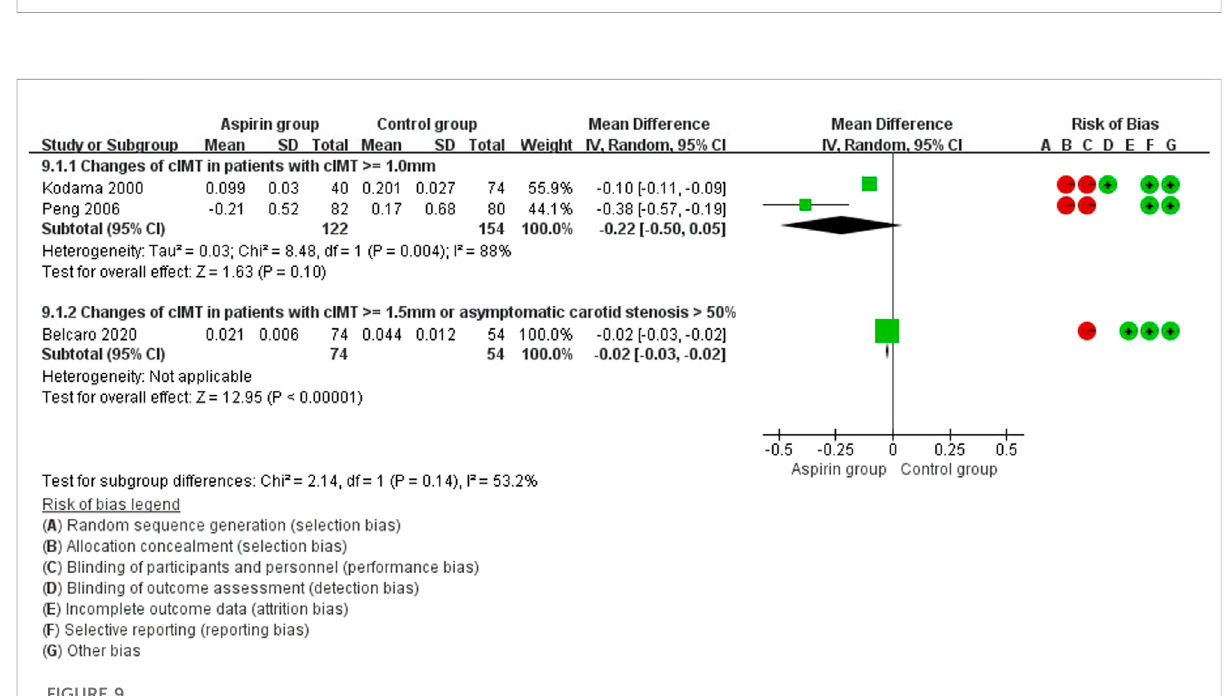
FIGURE 9 Forest plot of changes in carotid intima-media thickness (cIMT) in patients with cIMT ≥ 1.0